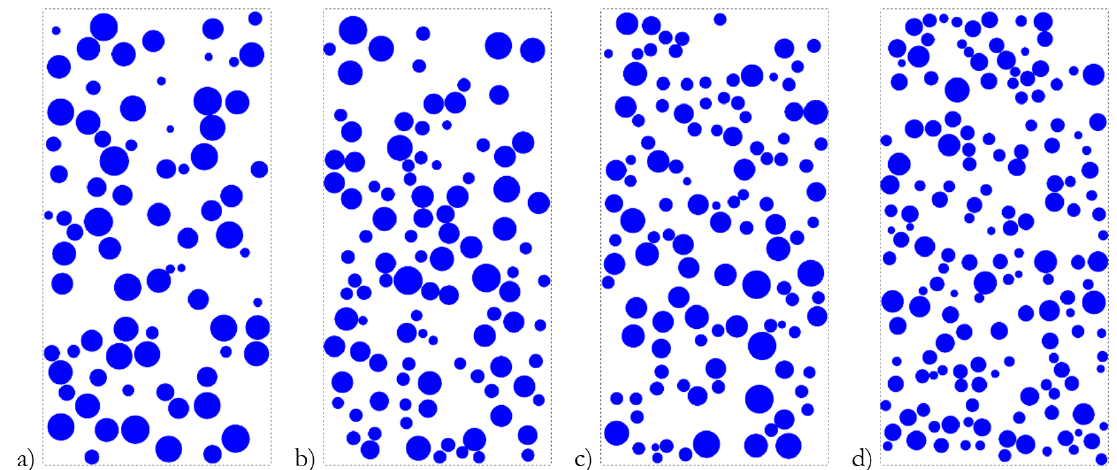
Figure 3 E xamples of the longitudinal section of samples containing 25% of aggregates and following the particle size distribution of each type: (a) 4/10-550-A (b) 4/10-430-A (c) 4/10-520-S (d) 4/8-750-S